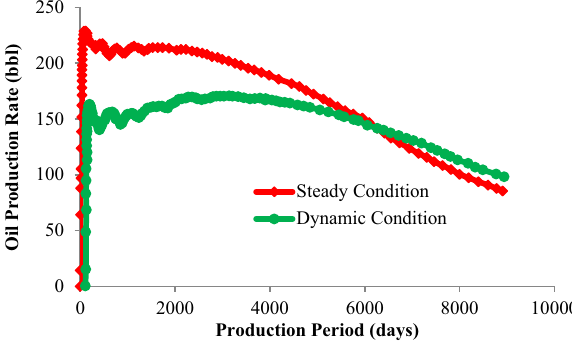
Fig. 11 Water cut with production period